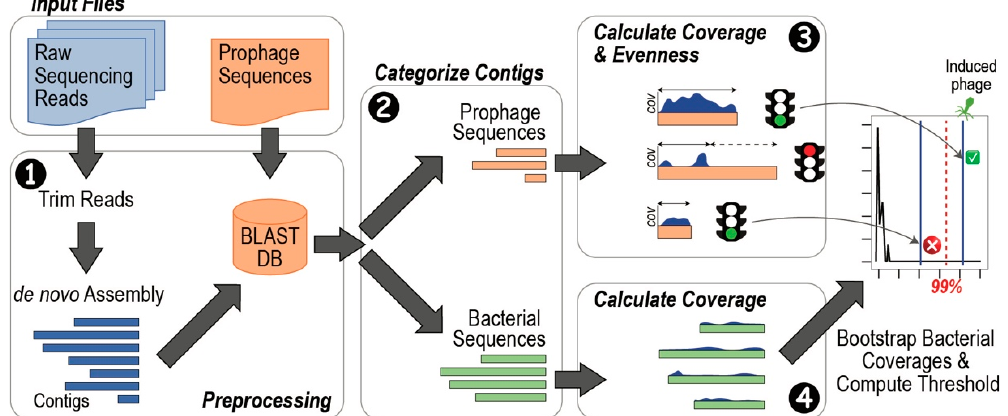
Figure 1. Schematic of PIE software. Required input files include raw sequencing reads (paired-end or single-end) and prophage sequence predictions (FASTA format file). Raw reads are trimmed and assembled ( ❶ ) and categorized via BLAST as prophage or bacterial in origin ( ❷ ). After categorization, sequence coverage is computed for both the prophage sequences ( ❸ ) and bacterial sequences ( ❹ ). For the prophage sequences, an additional metric is computed: evenness. Prophage sequences that do not have an evenness ≥ 90% are not considered further (red stop light). Prophage sequences meeting the evenness threshold (green stop light) are compared with the threshold for the distribution of bacterial contig coverage values (shown as 99% in the figure). Prophage sequences with a coverage exceeding the threshold are called as induced phages (“ √ ” in green box); prophage sequences that do not meet this threshold are not called as induced phages (“X” in red circle).